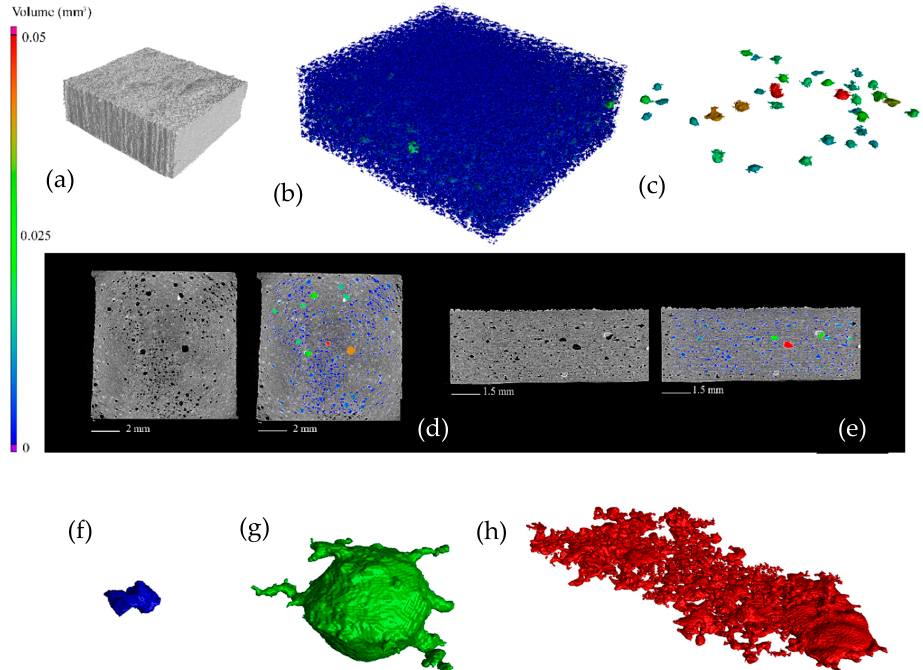
Figure 7. ( a ) 3D rendering of a sample fabricated with 0.110 J/mm 3 ; ( b ) total internal porosity; ( c ) only large defects; ( d ) interlayer slice with/without color-coded porosity; ( e ) side-view of porosity; ( f ) small, acute, pores; ( g ) spherical pores; ( h ) layered porosity.